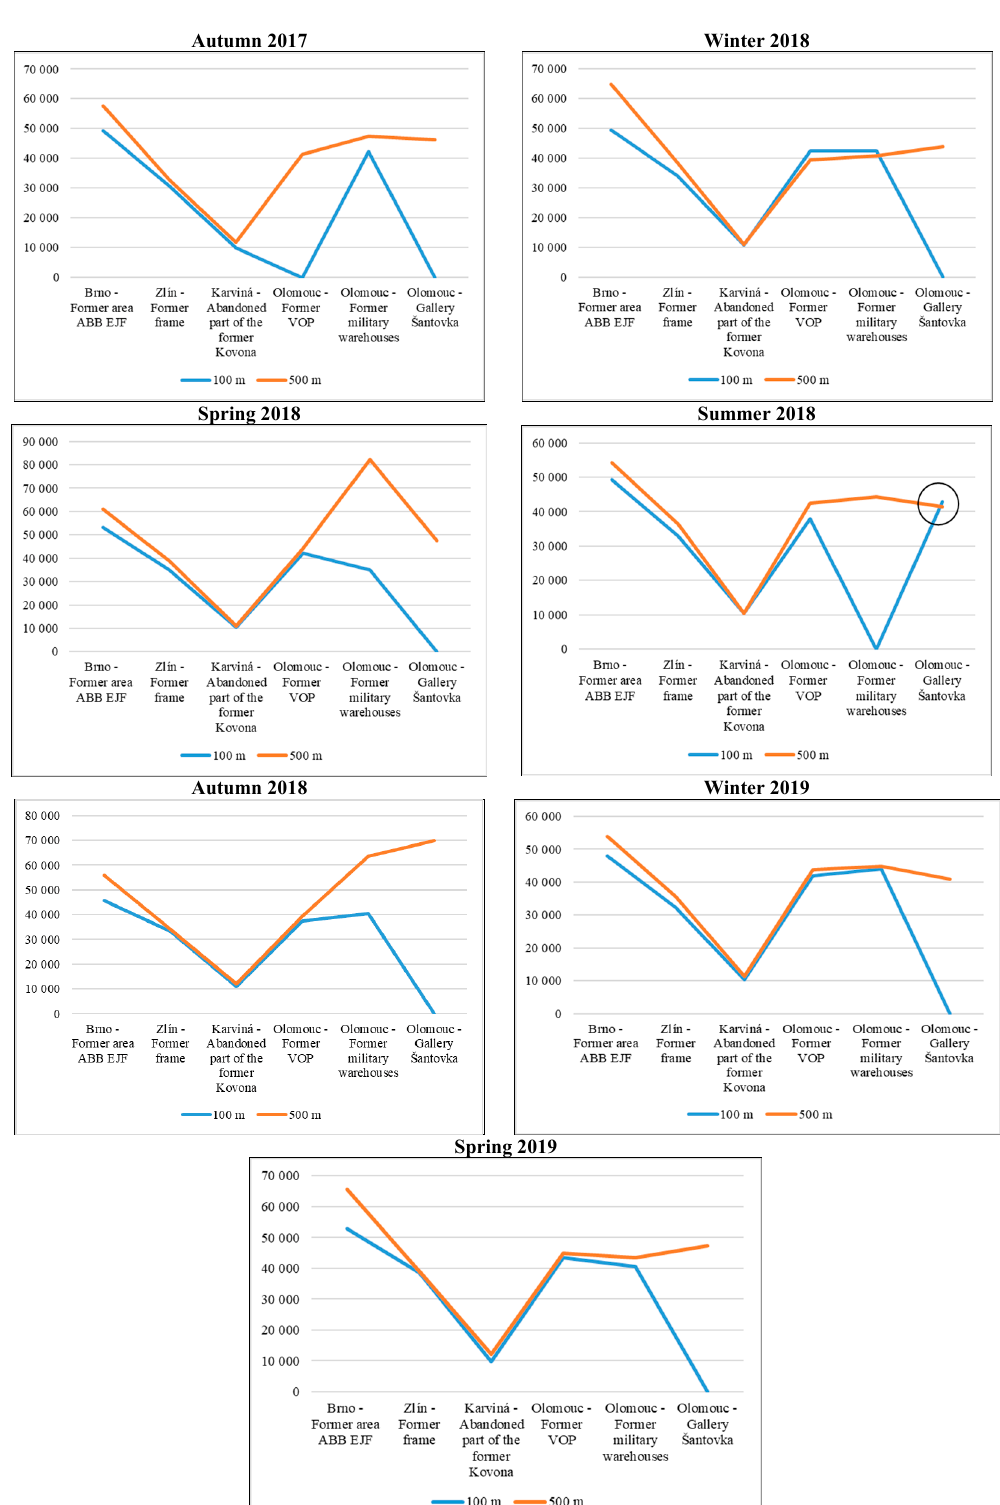
Figure A1. Property prices near brownfields by distance and period (in CZK/m 2 ). Source: own proceeding based on www.ceskereality.cz (accessed between 4 February 2017 and 7 December 2019).